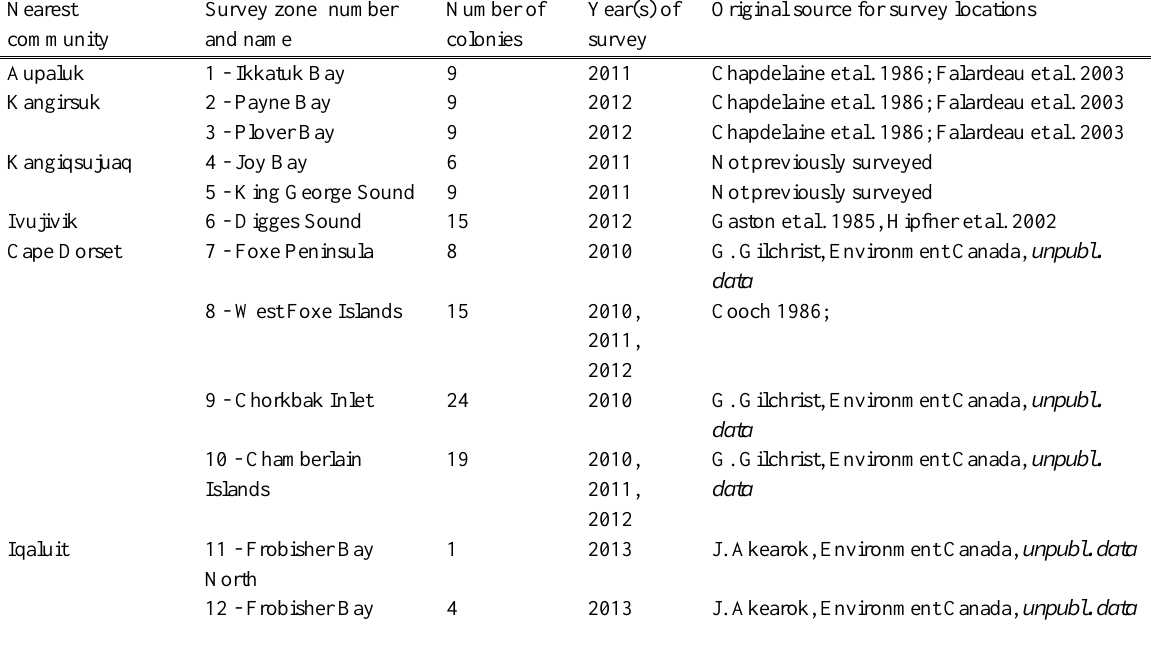
Table A1.1. Sampling effort summarized by survey zone. Survey zone number and name correspond to areas identified in Figure 1. Number of colonies refers to the number of Northern Common Eider colonies with ≥20 nesting pairs identified within each zone. Original source for survey locations refers to documentation by Canadian Wildlife Service of past survey